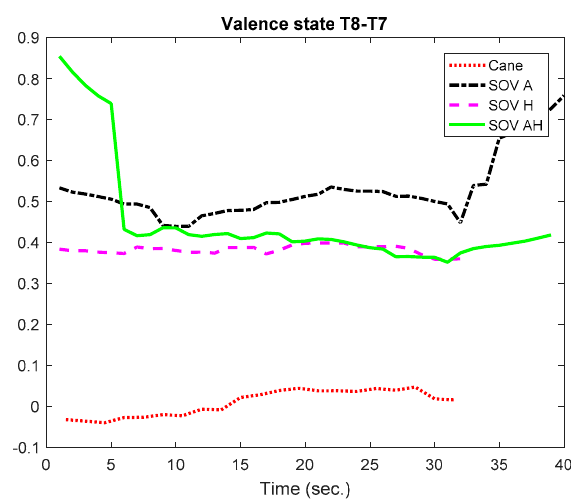
Figure 33. VS evolution in time for UserA.